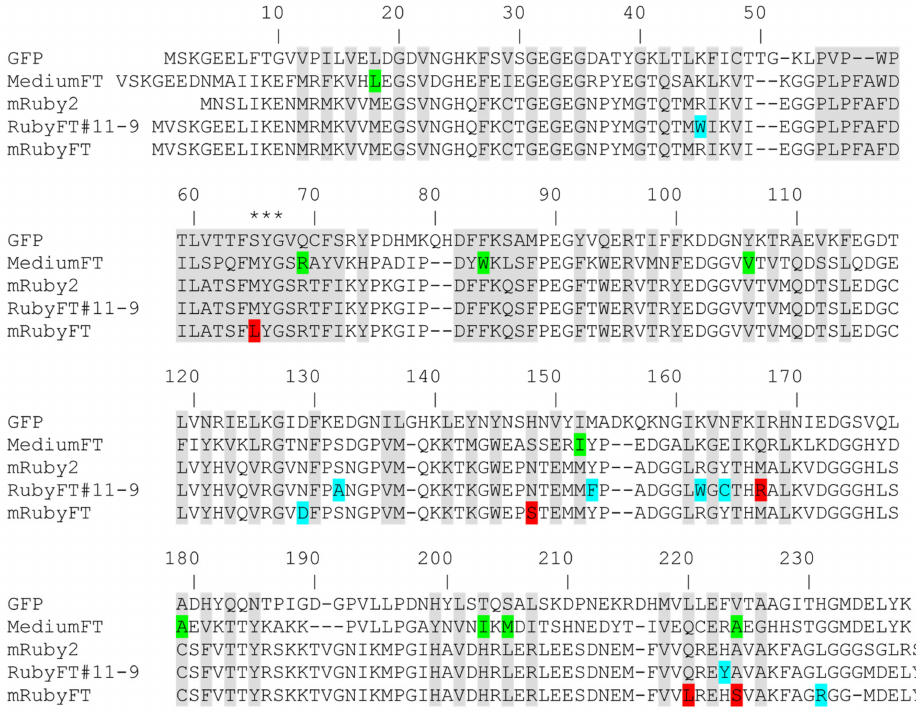
Figure 1. Amino acid sequence alignment for RubyFT and Medium-FT timers and GFP and mRuby2 fluorescent proteins. Alignment numbering follows that of Aequorea victoria GFP. The residues inside the β -barrel are highlighted in gray. Asterisks indicate three residues that form the chromophore tripeptide. Internal and external mutations in RubyFT timers relative to the mRuby2 original matrix are highlighted in red and cyan colors, respectively. In the case of Medium-FT, internal and external mutations relative to the mCherry protein are highlighted in